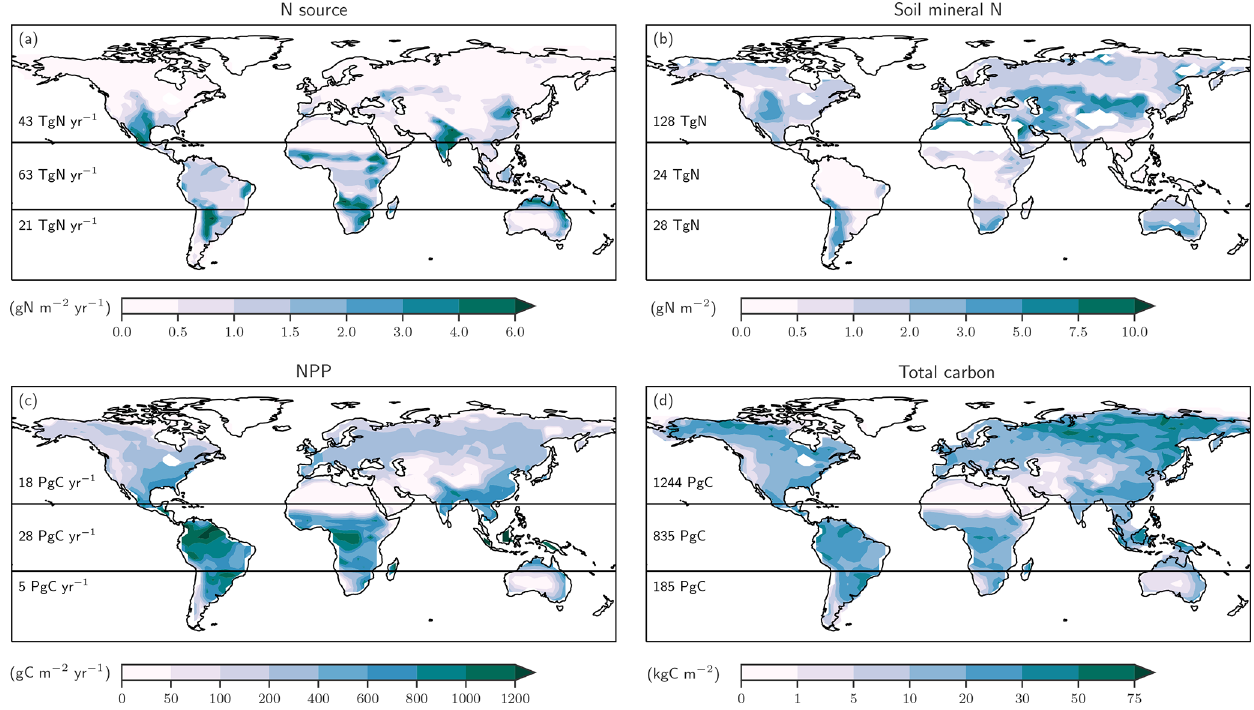
Figure 5. Preindustrial patterns of the input flux of new nitrogen (N) into ecosystems (a) , the bioavailable concentration of N in the form of ammonium and nitrate in soils (b) , net primary productivity (c) , and total carbon in the land biosphere (d) as simulated by LPX-Bern(v1.4N). The N source in (a) does not include the prescribed N deposition. Deserts with high mineral nitrogen concentrations are masked for clarity in (b) . Numbers indicate integrated values for three latitudinal bands (90–20 ◦ S; 20 ◦ S–20 ◦ N; 20–90 ◦ N).